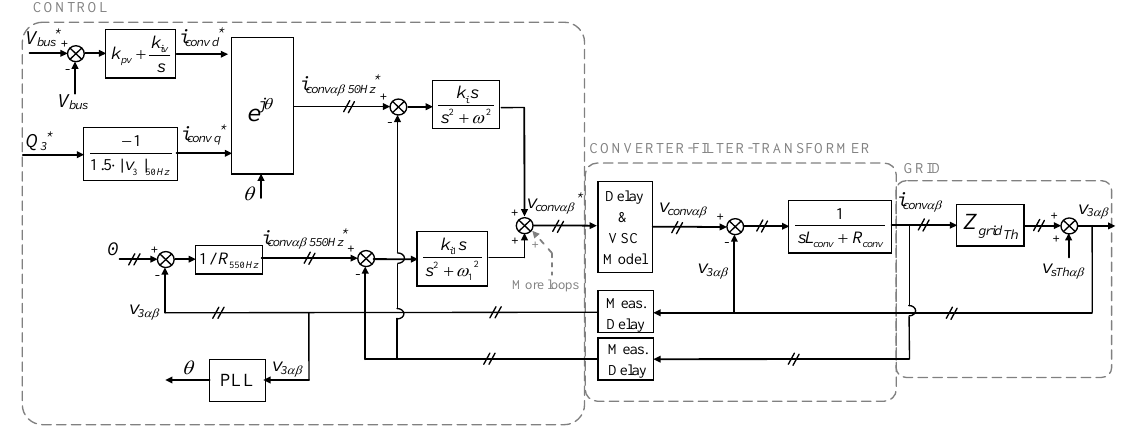
Figure 7. Control block diagram of ACISEF, with current loops in the stationary reference frame ( αβ ). There can be as many loops as there are active impedances to implement.